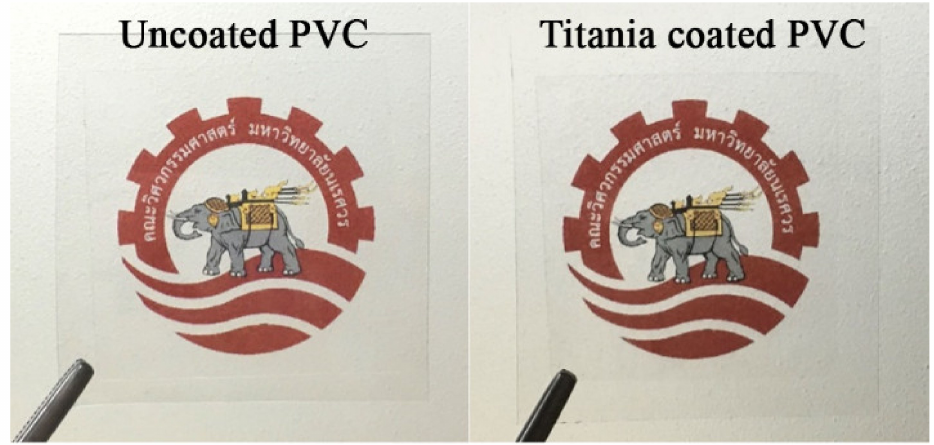
Figure 2. Photo of uncoated PVC and TiO 2 -coated PVC